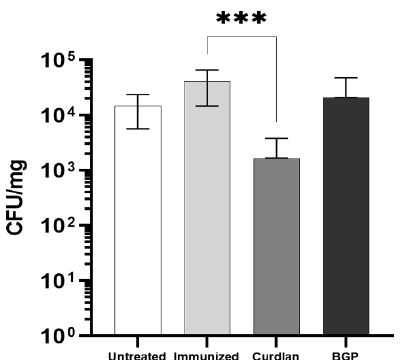
Figure 11. Quantification of the pulmonary fungal burden in C57BL/6 mice subjected to the HK- C. gattii immunization protocol, with or without the administration of curdlan. C57BL/6 mice received curdlan (200 µg/mouse), BGP (200 µg/mouse), or PBS i.p. on day 0. On days 3, 17, and 31, they were immunized with 2 × 10 7 HK- C. gattii -thin yeast cells or administered PBS i.n., with an interval of 14 days between immunizations. On day 45 (14 d.p.i.), the mice were infected with C. gattii . On day 59 (14 days post infection), the mice were euthanized, and the pulmonary fungal burden was quantified using the CFU (colony-forming units) assay and normalized to the lung mass (CFU/mg). The results are expressed as mean ± SD. *** p < 0.001.